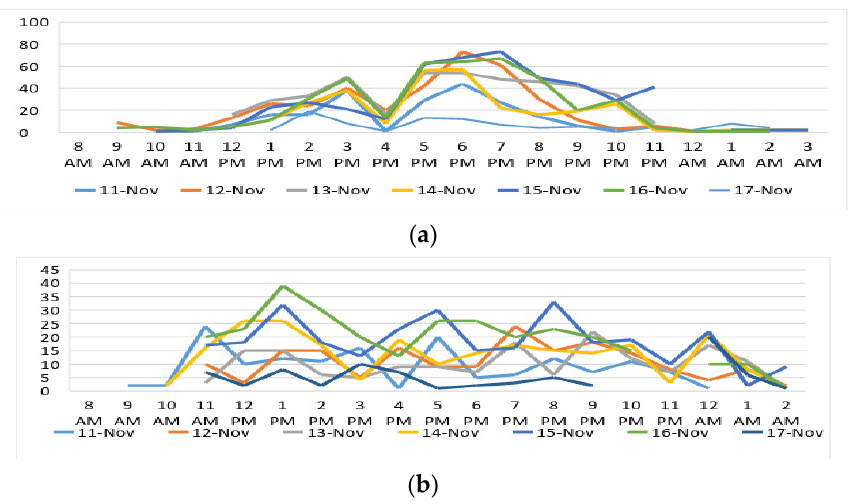
Figure 2. Typical external truck ( a ) departures and ( b ) arrivals patterns in Alexandria container terminal in November 2017